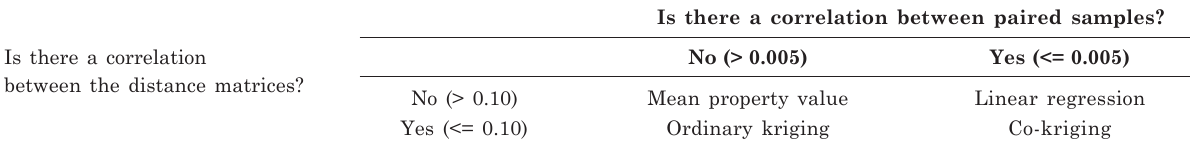
Source: Adapted from Ciampalini et al. (2012).